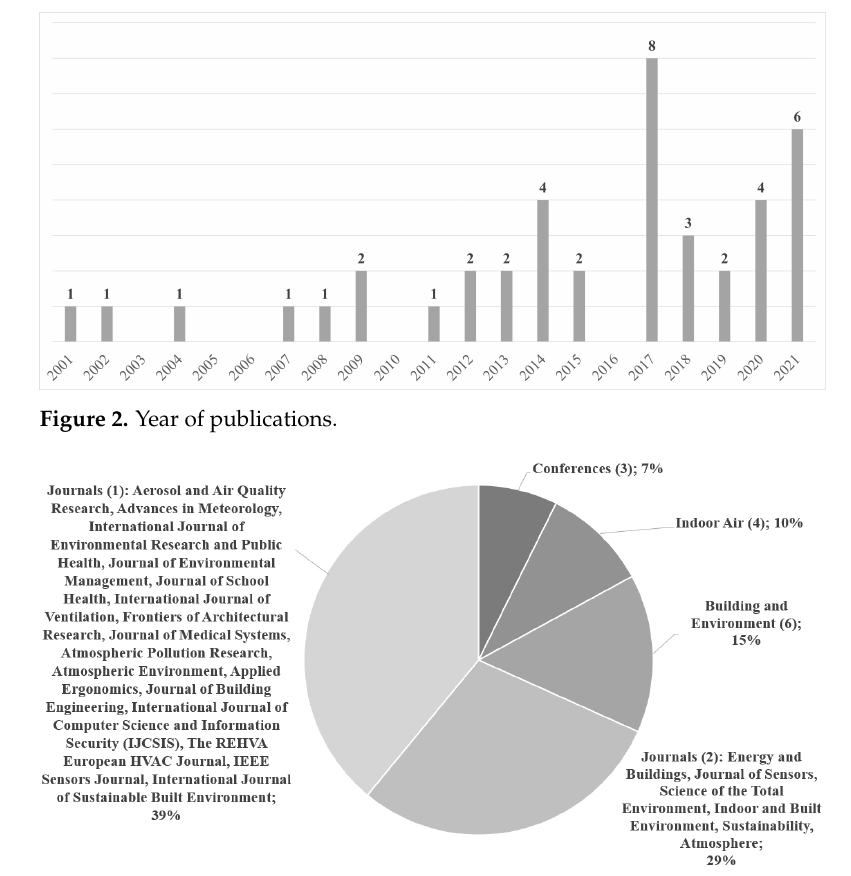
Figure 3. Publication